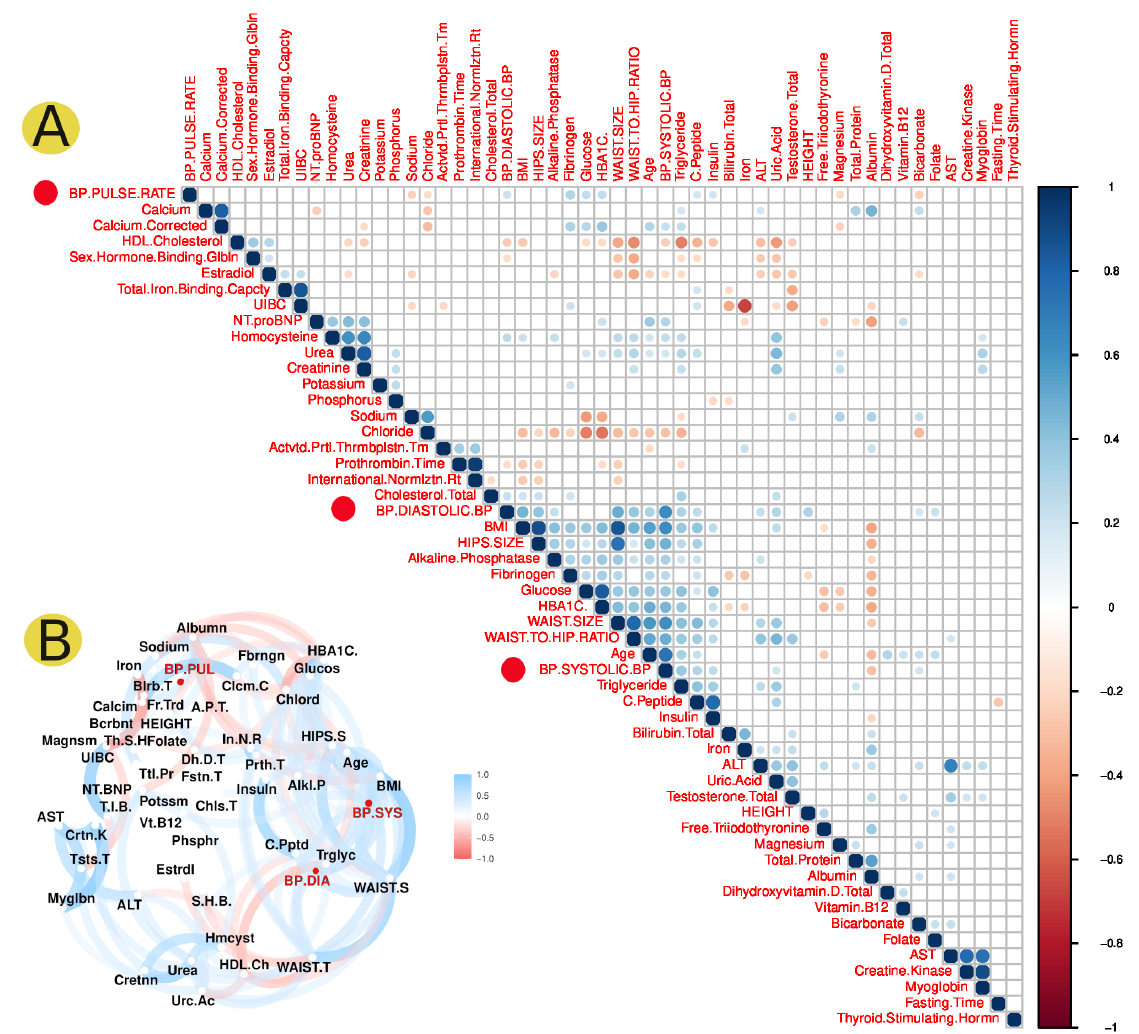
Figure 3. The statistical correlation analysis of hypertension data. The correlation analysis of different clinical parameters from the 200 Qataris obtained from QBB, with blood pressure parameters highlighted in red circles. ( A ) Graph of a correlation matrix showing positive and negative correlations with significance indicated by p values less than 0.01. ( B ) A correlation network graph displaying the statistical interaction between various clinical parameters, including blood pressure factors in red.